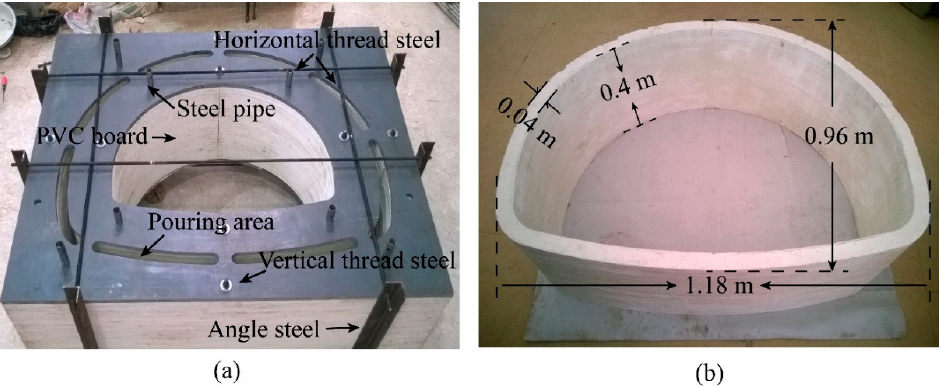
Figure 12. Model mold and tunnel model: ( a ) Self ‐ made mold made of polyvinyl chloride (PVC) board; ( b ) Completed tunnel model.